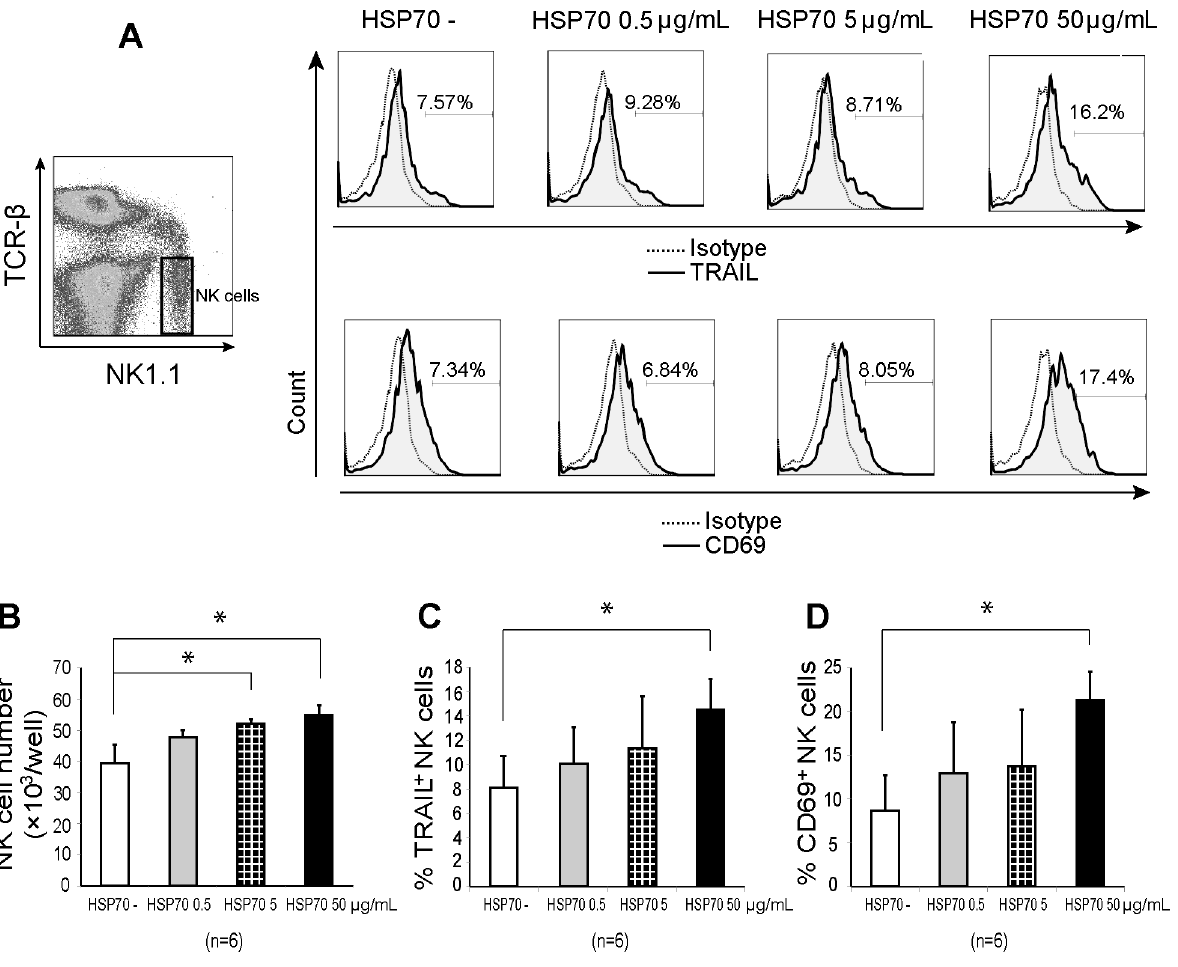
Figure 7. The effect of recombinant heat shock protein 70 on natural killer cell proliferation and TRAIL and CD69 expression. Isolated liver lymphocytes (2 million cells/well) were cultured with mouse recombinant heat shock protein (HSP) 70 at various concentrations: 0, 0.5, 5, or 50 m g/mL. After 3 days of culture, the lymphocytes were harvested for phenotypic determination. (A) Representative flow cytometric analysis of TRAIL and CD69 expression in TCR b 2 NK1.1 + natural killer (NK) cells is shown. The dotted lines represent the expression distribution in the negative control cells and the solid lines (shaded areas) with numbers indicate the distribution of TRAIL + and CD69 + NK cells. (B) TCR b 2 NK1.1 + NK cell number per well, (C) TRAIL + and (D) CD69 + NK cell percentages are shown in bar graphs as mean plus standard deviation (n=6). Data were statistically analyzed using the independent samples T test; * p , 0.05.